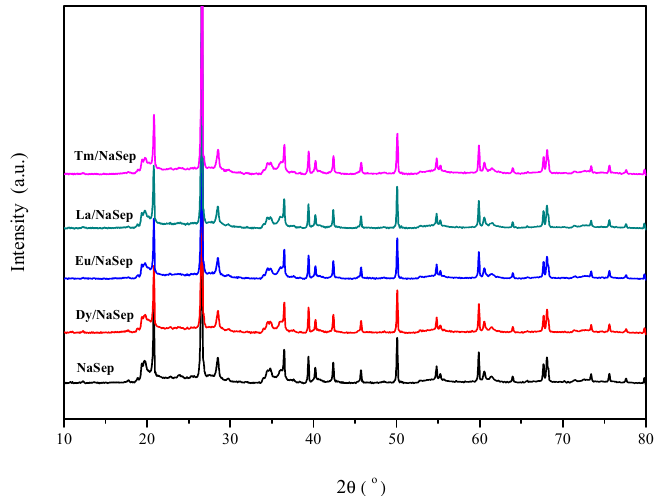
Figure 1. XRD patterns of sodium-treated sepiolite (NaSep), Eu/NaSep, Dy/NaSep, La/NaSep, and Tm/NaSep.